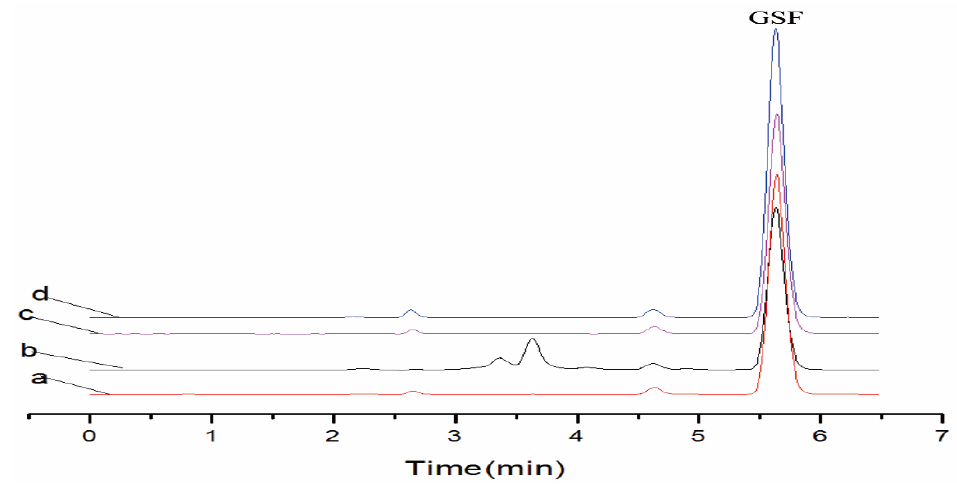
Figure 5. Recovery chromatograms of drug standard, surface and deionized water samples. ( a ): Drug standard 10 µg/mL; ( b ) spiked surface water sample by using SNIPs after DSPE; ( c ): spiked surface water sample by using SMIPs after DSPE; ( d ): spiked deionized water sample by using SMIPs after DSPE.